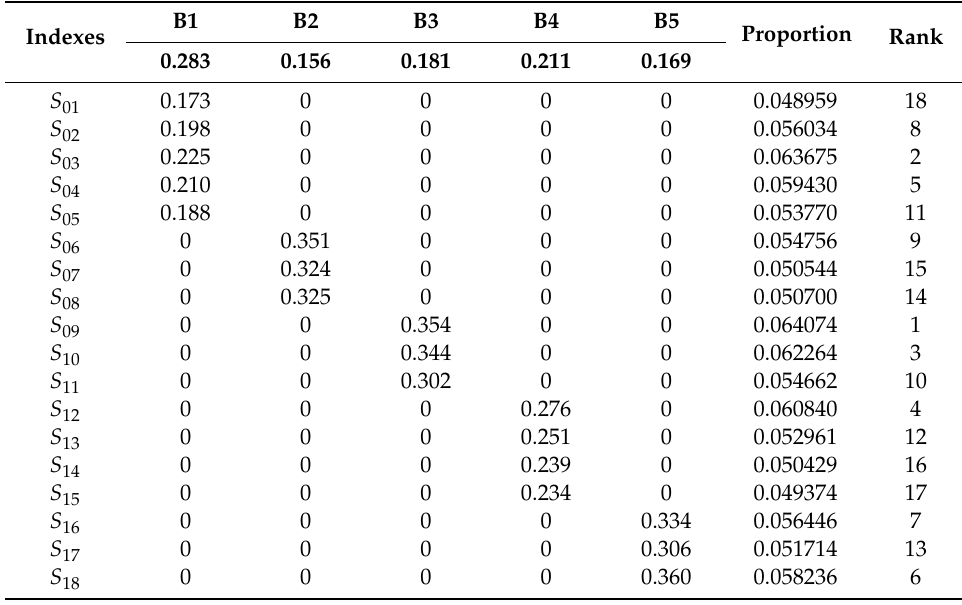
Table 3. The results of weight and rank of the evaluation